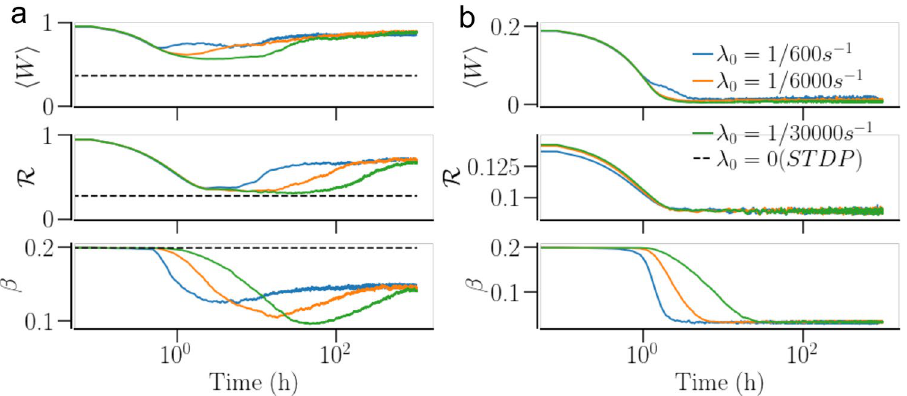
Figure 7. Time evolution of the dynamical measures with different pruning rates (and hence different embodiments of SP) for a network of non-identical oscillators. ( a ) Shows the time traces of the mean synaptic weight, (cid:31) W (cid:30) , the order parameter, R , and the mean In-NDD, β , for a synchronized state and ( b ) shows the same for a desynchronized state. The dashed lines show steady-state values of (cid:31) W (cid:30) , R , and β for the network with STDP only. Note the different scales of the mean synaptic weight and the order parameter in ( a ) and ( b ). Parameters are a = 0.3 , γ = 15 .